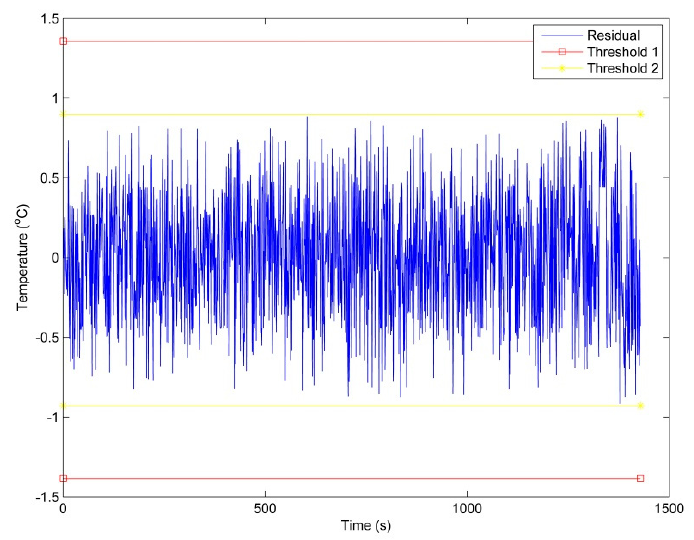
Figure 8. Residual control diagram of a normal operating gearbox tank.